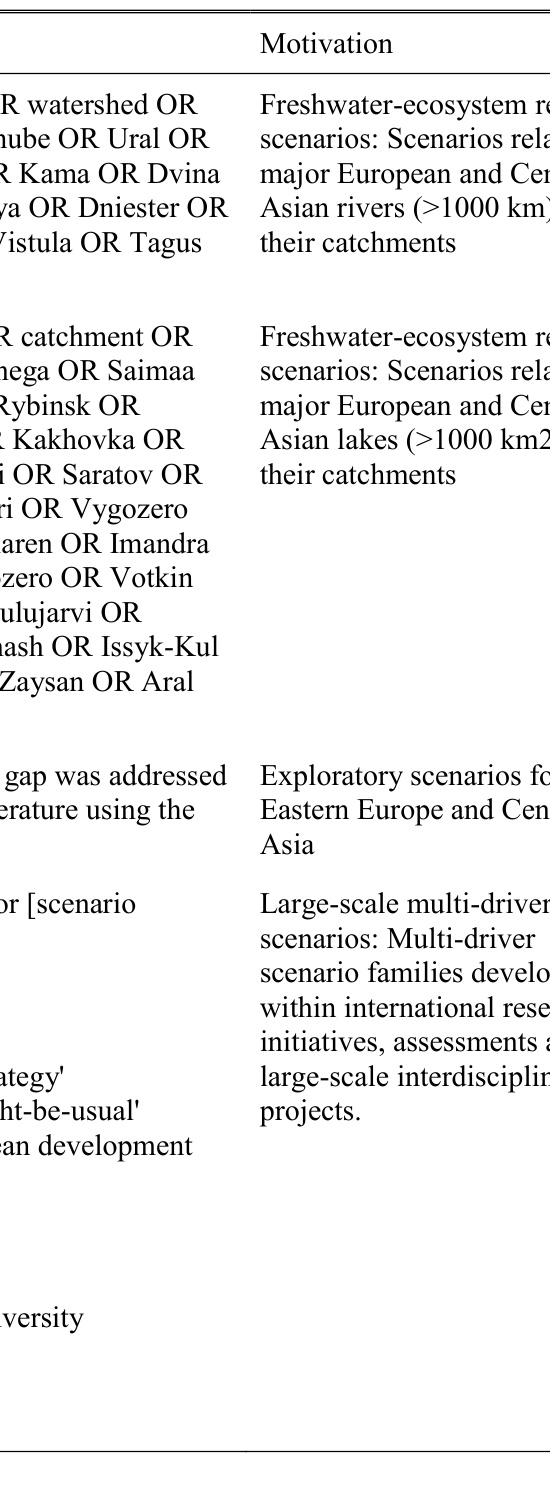
Table A2.2: Search terms used for the targeted searches.